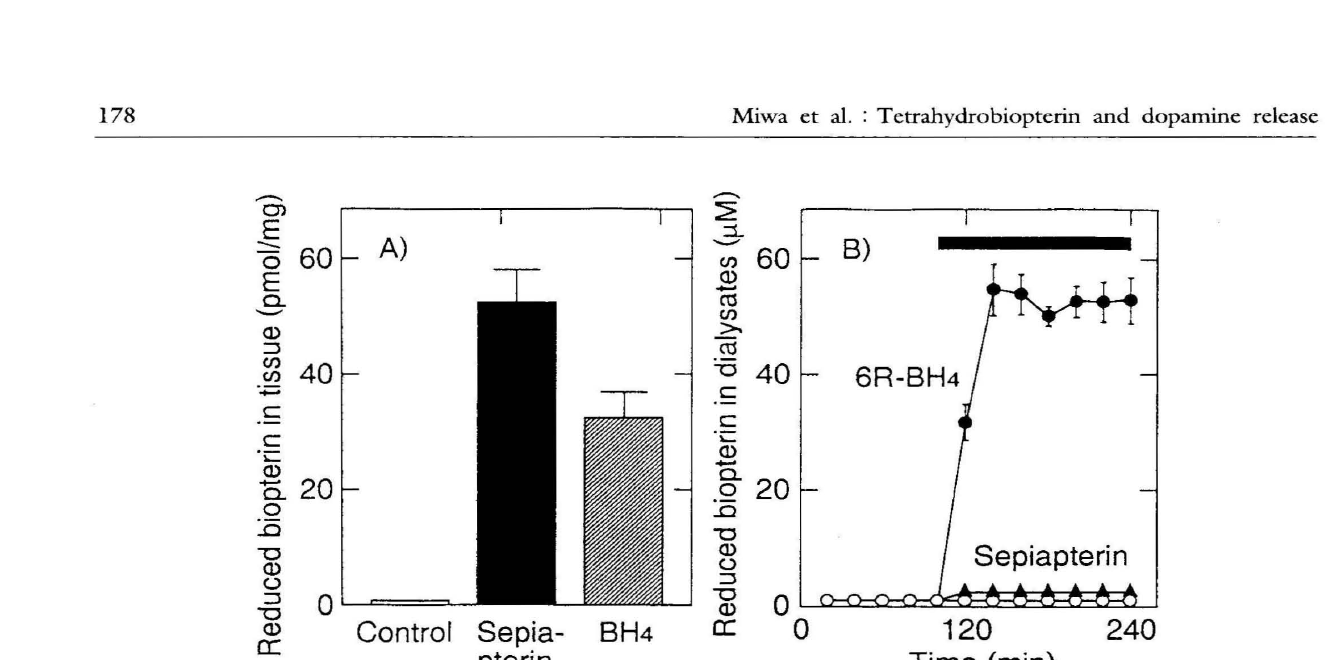
Figure 5. Effects of sepiapterin or 6R-BH added to the perfusion fluid on tissue (A) and extracellular (B) levels of 4 reduced biopterins in the striarum. (A) Brain microdialysis was performed with perfusion fluid containing 1 mM sepia pterin or 6R-BIL for 140 min. At the end of microdialysis, rats were decapitated and the striata on the dialyzed side were removed for determination of tissue levels of reduced biopterin. (B) The striatum was dialyzed with a double·bar relied probe, which was a probe complex consisting of a pair of I-shaped probes. One probe of the complex was perfus ed with Ringer solution containing 1 mM sepiapterin (filled triangles) or 6R-BIL (filled circles) for their administration during the time indicated by a bar, and the other was perfused with Ringer solution alone for collection of biopterins in the extracellular fluid. Empty circles represent the control group which was perfused in the absence of pteridines. Each value is the mean ± SEM of four determinations.